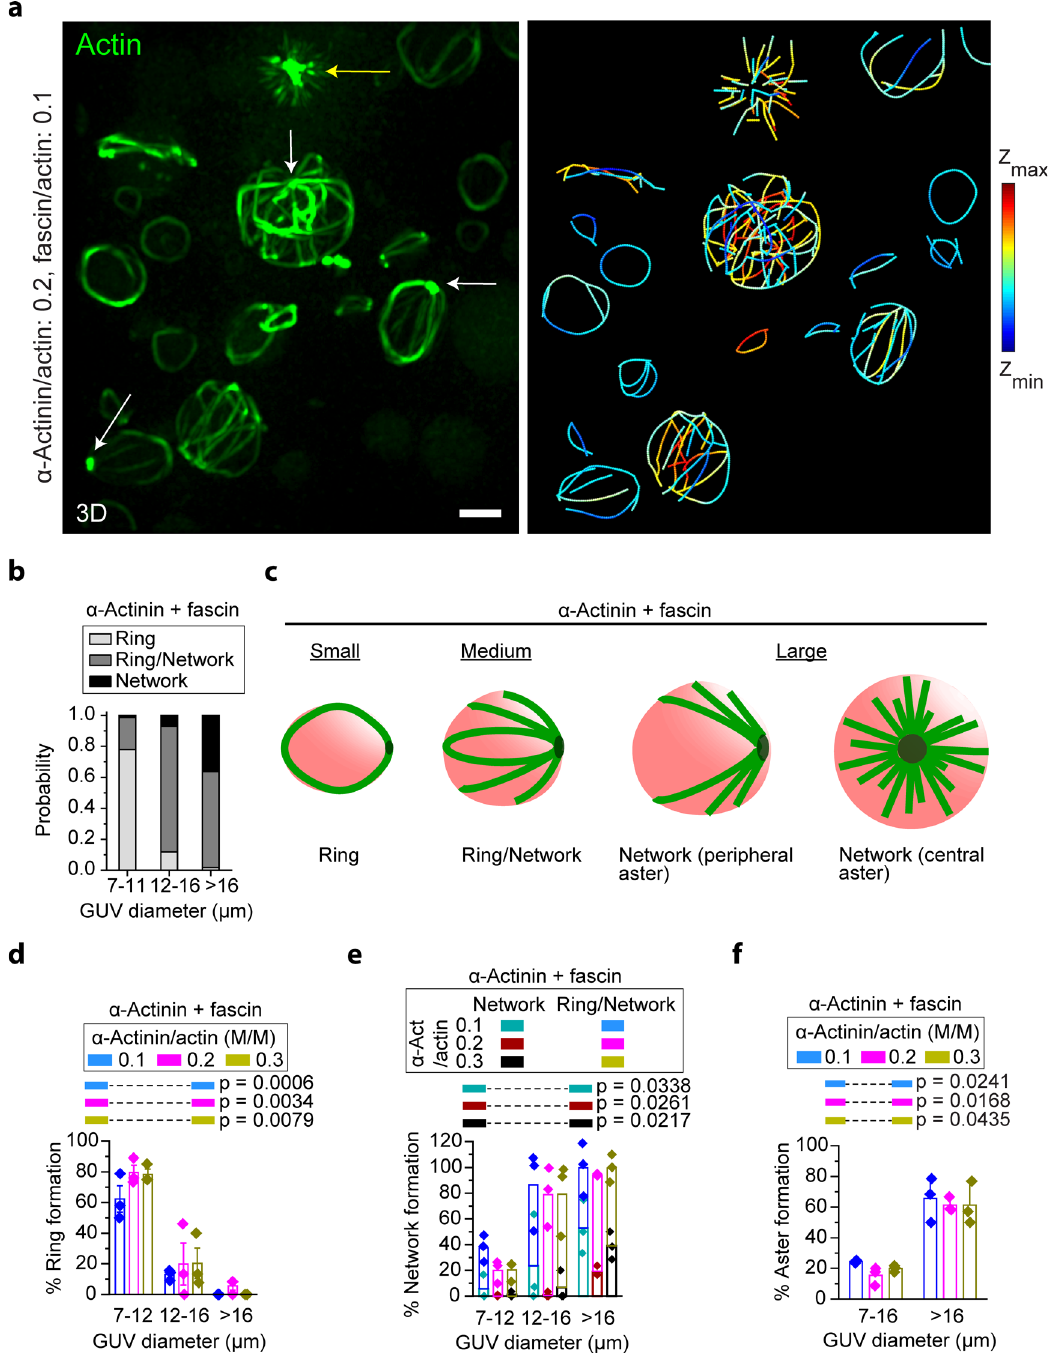
Fig. 2 GUV-size-dependent formation of rings, peripheral asters, and central asters by α -actinin and fascin. a Representative 3D-reconstructed (left) and skeletonized (right) images from a confocal fl uorescence image stack of 5 µ M actin (10% ATTO-488 actin) bundled by 0.5 µ M fascin and 1 µ M α -actinin in GUVs (composition: 69.9% DOPC, 30% cholesterol, and 0.1% rhodamine-PE). Yellow arrow denotes a cluster of actin fl uorescence in a central aster. White arrows denote clusters of actin fl uorescence in peripheral asters. Color in the skeletonized image shows z position. Scale bar, 10 μ m. b Cumulative probability ( α -actinin concentrations of 0.5, 1, and 1.5 µ M with 0.5 µ M fascin and 5 µ M actin) of ring and network formation in GUVs with different sizes. c Schematic representation of GUV-size-dependent actin networks assembled by α -actinin and fascin. Rings and peripheral asters can occasionally deform GUVs. d , e Probability of the formation of rings ( d ) and networks ( e ) at different α -actinin concentrations as a function of GUV diameter. N GUVs per experiment = [101 98 29], [147 58 71], [137 82 24] in order of ascending α -actinin concentration (numbers in brackets are arranged in order of ascending GUV diameter). p values compare formation probabilities of rings ( d ) and networks ( e ) in small and large GUVs. f Probability of aster formation (peripheral or central) in the presence of fascin and α -actinin. Aster formation depends on GUV size but not α -actinin concentration. Fascin/ actin, 0.1 (M/M). All error bars indicate standard error of the mean; n = 3 experiments. N GUVs per experiment = [199 29], [205 71], [219 24] in order of ascending α -actinin concentration (numbers in brackets are arranged in order of ascending GUV diameter). p values compare aster-formation probabilities in the two ranges of GUV